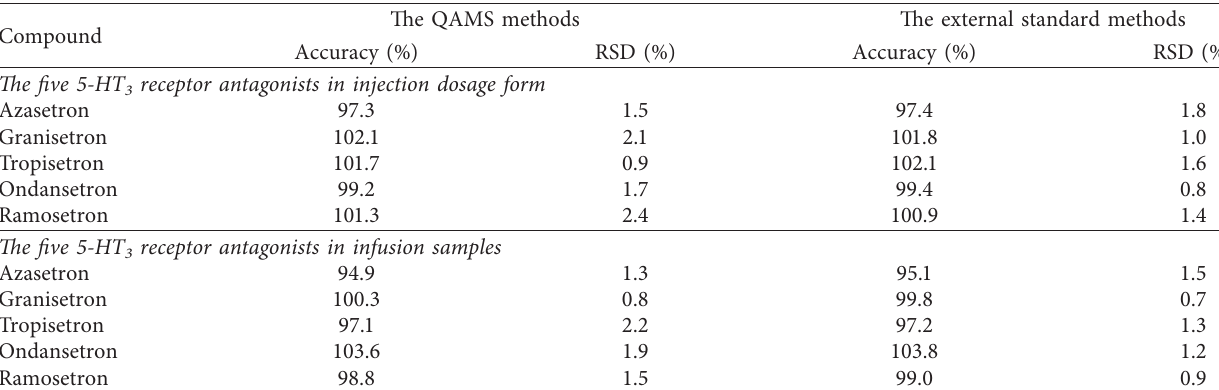
Table 7: The results obtained by the QAMS and ESM methods ( n �